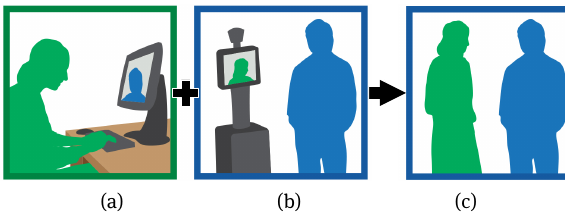
Fig. 1. Social telepresence definition [75]. The robot’s user (green person in ( a )) operates a telepresence robot in a remote environ- ment (left side of image ( b )). In this interpersonal communication use case, the user converses with an interactant (blue person in ( b )). The degree to which the user feels telepresent with the inter- actant in the remote environment and vice versa ( c ) is dependent upon the quality of both the user’s human-computer interaction (a) and the interactant’s human-robot interaction